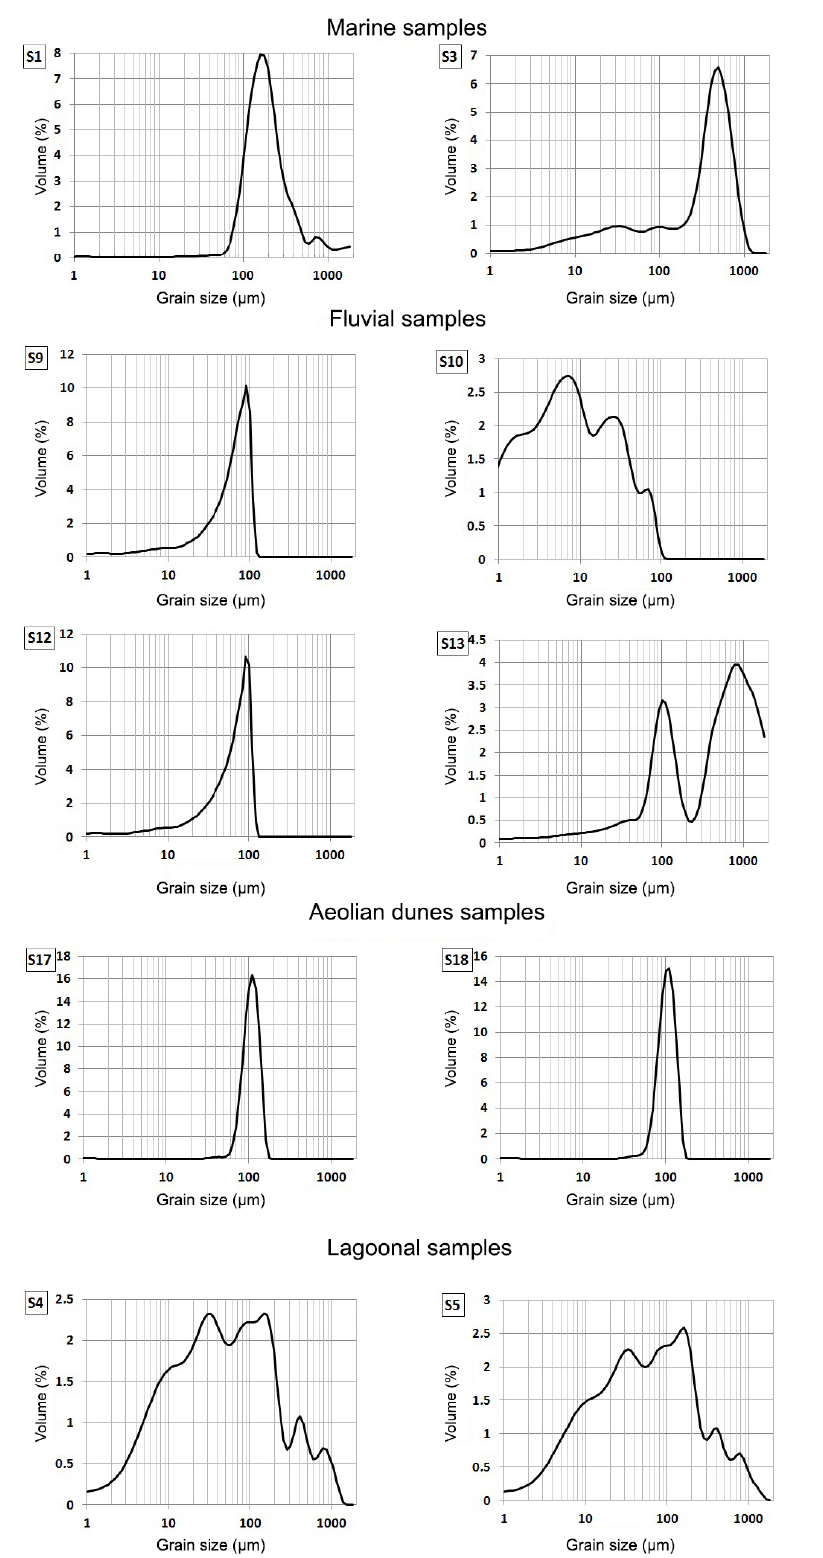
Figure 5. Particle size distributions (<2000µm) of representative samples from the catchment basin and the El Bibane